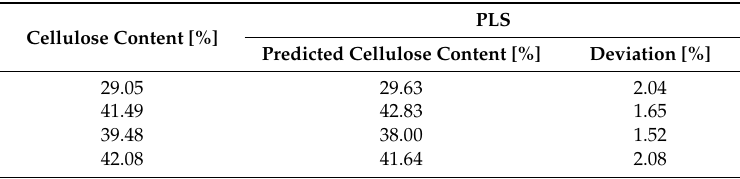
Table 3. Example results of determinations of cellulose content in buckwheat straw samples based on the obtained PLS calibration